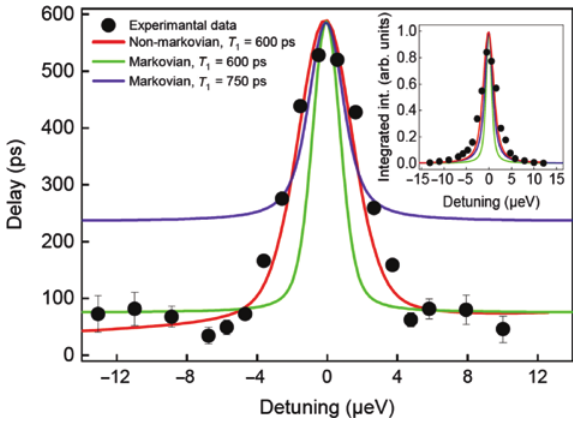
Figure 2: Time delay as a function of spectral detuning between the laser and the TLS. The red line and black dots correspond, respectively, to the non- Markovian simulations and the experiment as discussed in the main text. Green and blue lines show the simulation obtained via the Markovian approximation. Inset: Integrated intensity of the scattered pulses as a function of detuning. © 2019 American Physical Society, reprinted from